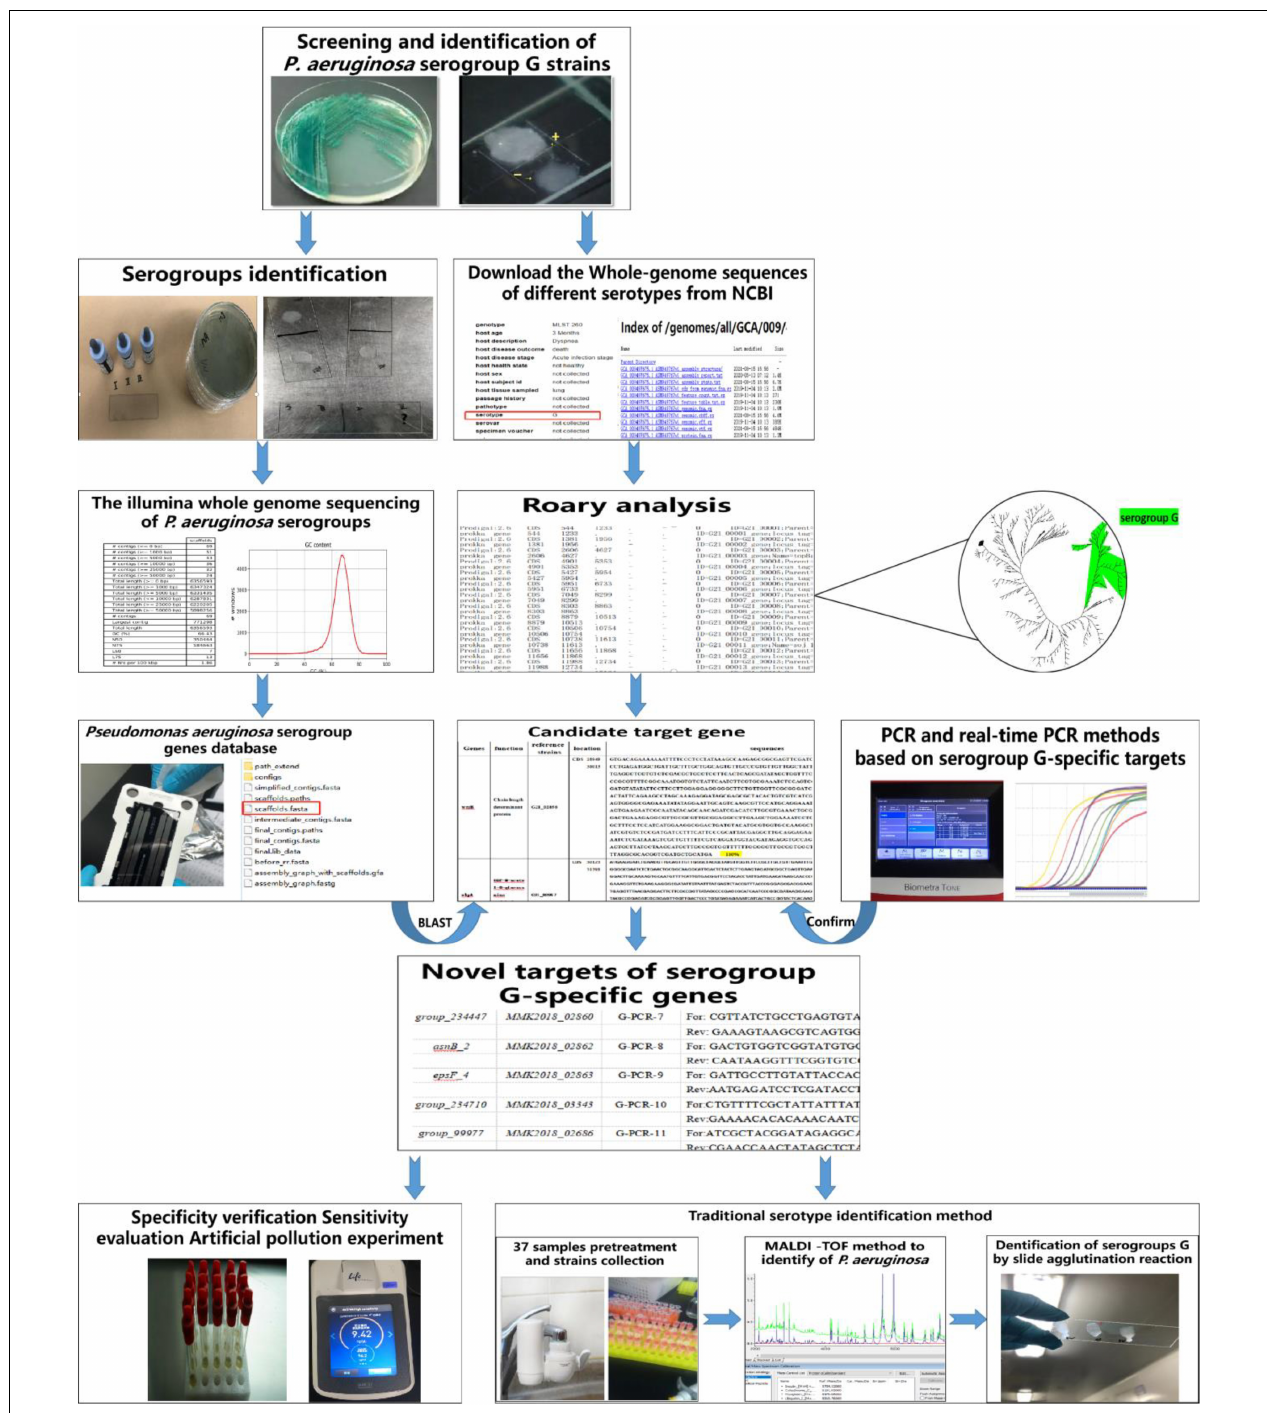
FIGURE 1 | The flowchart of the experimental method involved in this study.